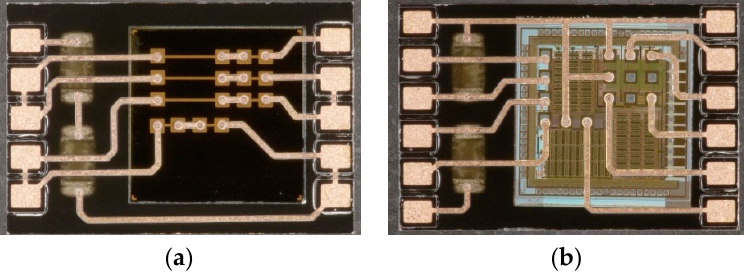
Figure 8. Manufactured ASIC packages by FOWLP/PLP; ( a ) daisy chain package, ( b ) functional package.